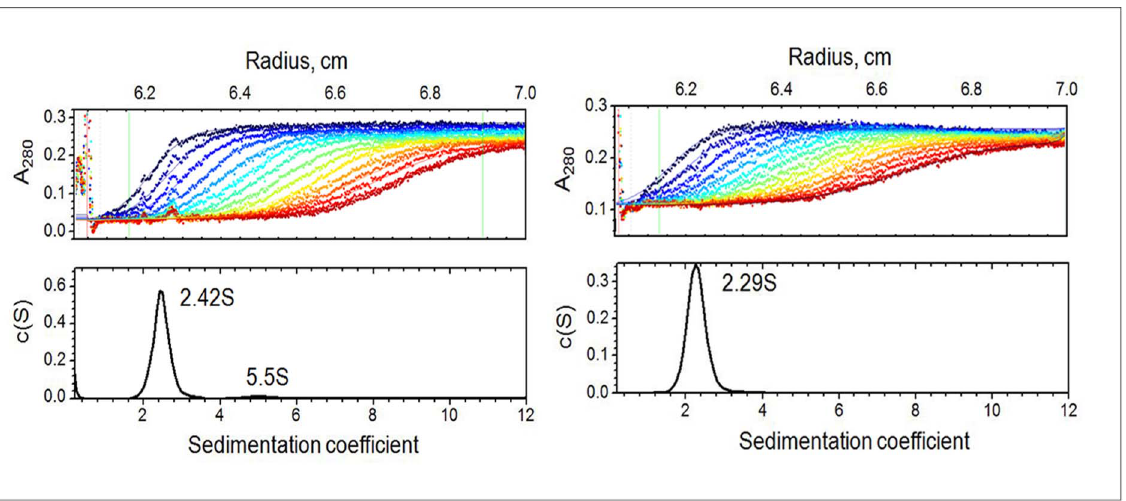
Figure 1. Sedimentation velocity experiment on the M1 protein (left) and the NM-domain (right). Top panels, raw data; absorbance at 280 nm plotted as a function of the radial position, every fifth curve is shown; lower panels, fitted distributions of the sedimentation coefficients.